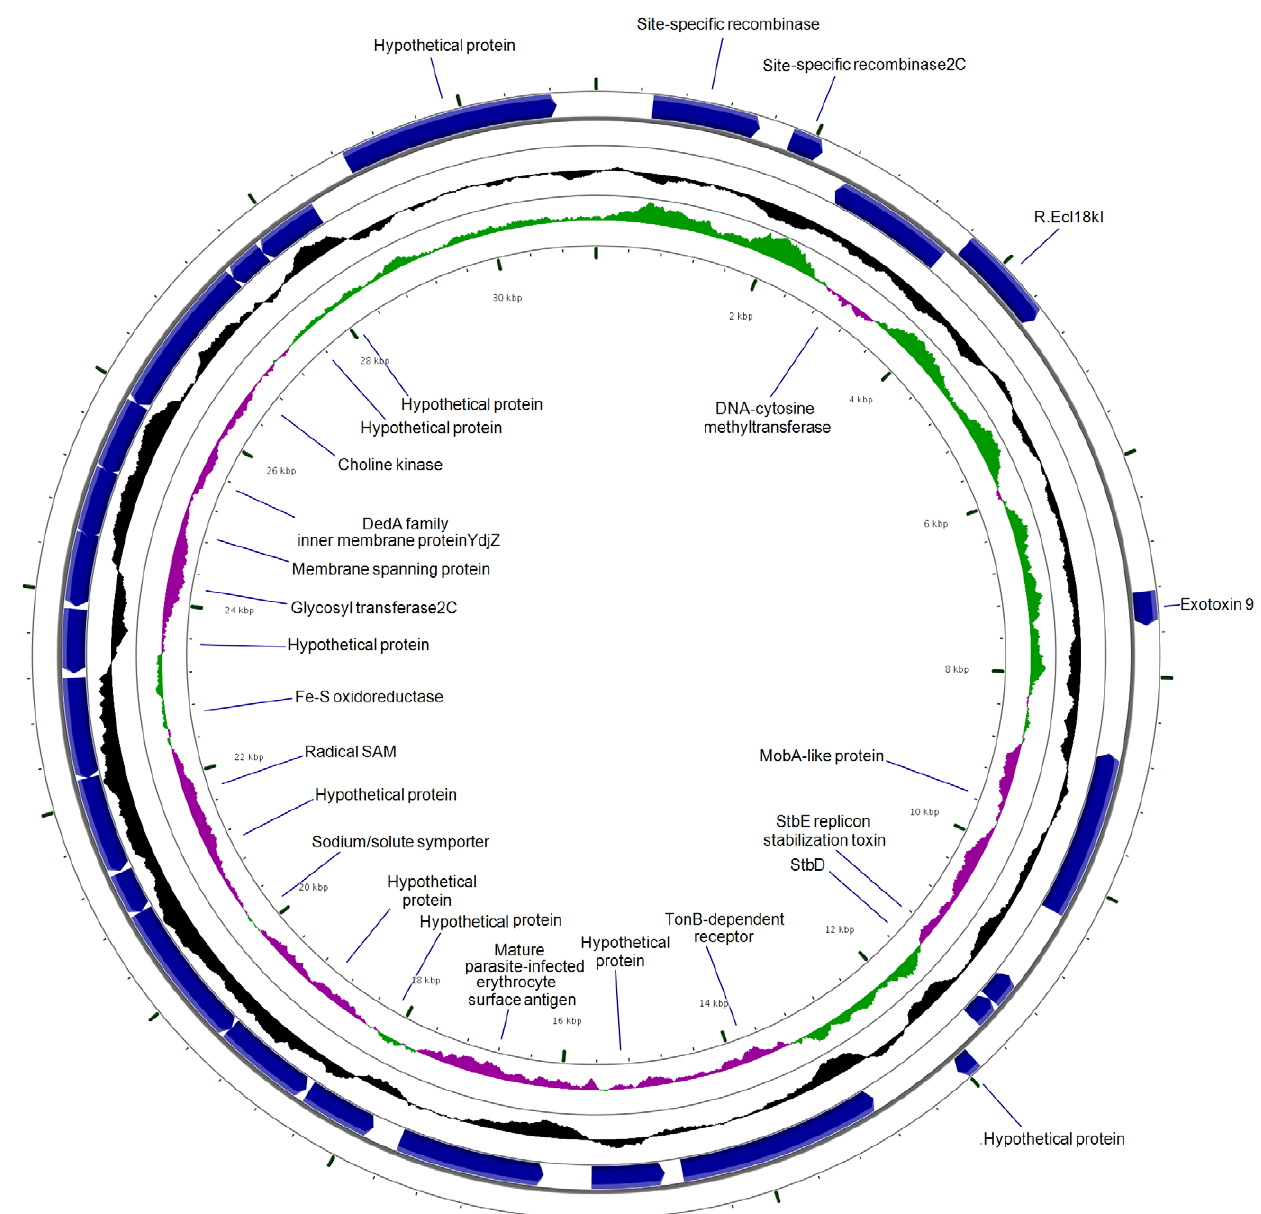
Figure 4. Graphical representation of the genes encoded by the plasmid purified from Campylobacterconcisus UNSWCD. Outer circle (blue) represents the coding sequences within the plasmid; inner circle (black) represents the GC content; inner circle (purple/green) represents the GC skew.